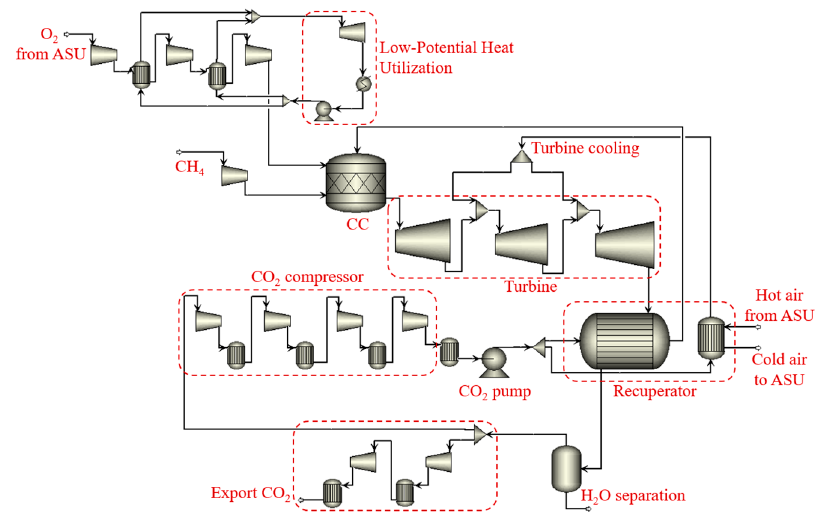
Figure 3. The mathematical model of the Allam cycle in Aspen Plus. Processes of expansion and compression in turbo-machines are calculated with con- stant isentropic efficiency according to the equations shown below.